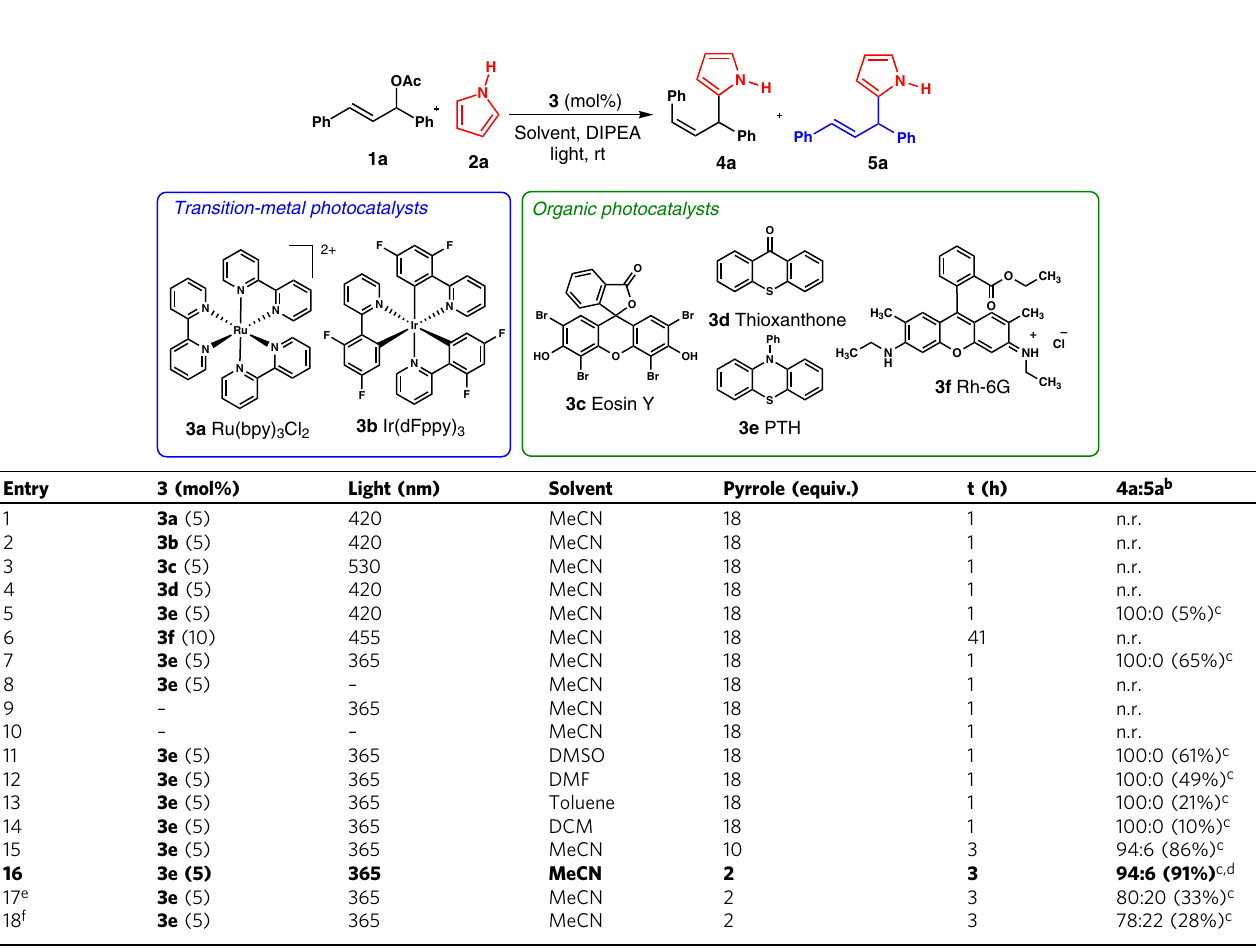
PhOAc 3 (mol%) Ph Solvent, DIPEA light, rt Transition-metal photocatalysts Organic